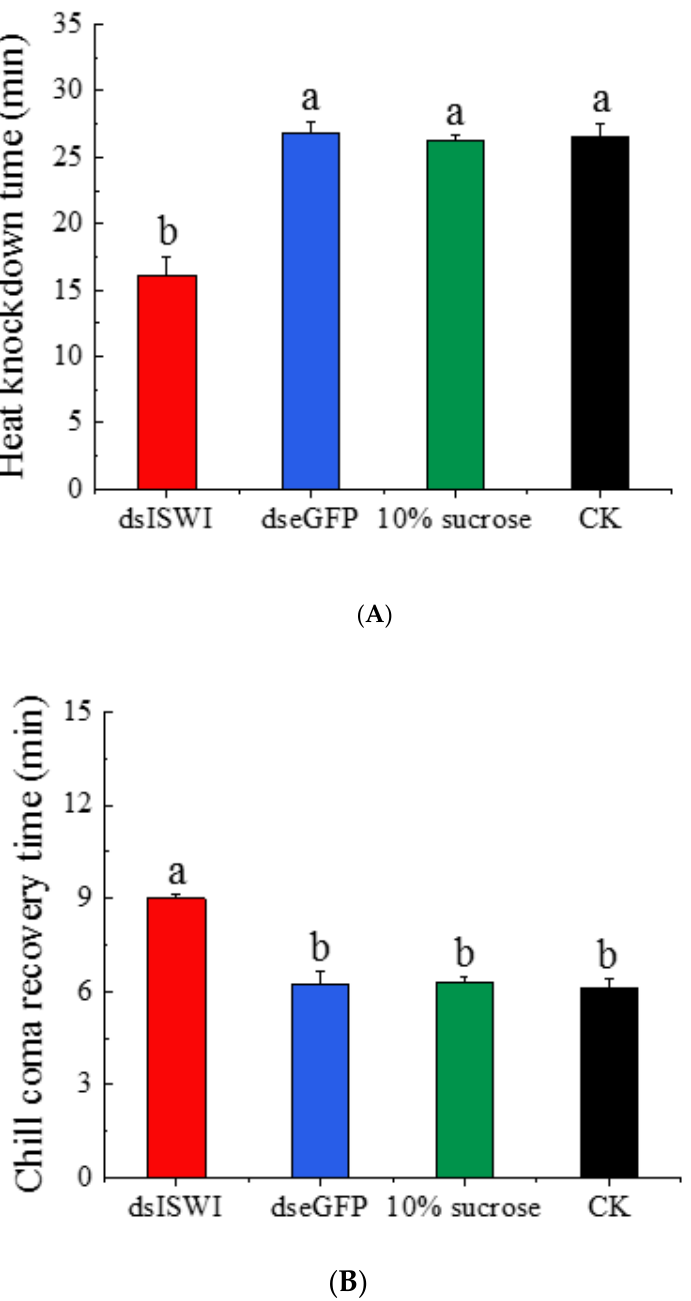
Figure 7. Mean heat tolerance time and chill coma recovery time after double-stranded RNA (dsRNA) feeding in MEAM1 adults. Compared with the control groups (whiteflies untreated or fed dseGFP or 10% sucrose), the mean heat tolerance time for whiteflies fed dsISWI was significantly decreased ( A ), whereas the mean chill coma recovery time was significantly increased ( B ). The data are presented as the mean ±SEM; N = 200. Bars with different lowercase letters are significantly different at p < 0.05.